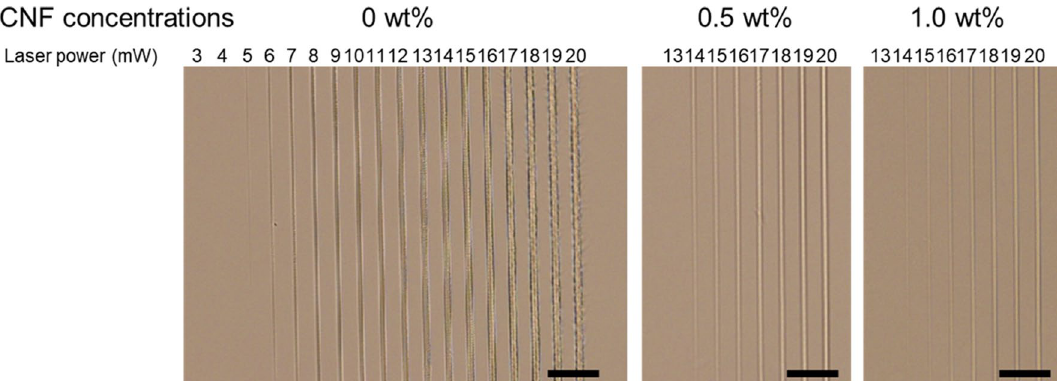
Figure 1. Optical microscope images of the fabricated microstructure by MPP at different concentrations of CNFs. The laser scanning speed was 50 µm/s. Scale bars indicate 50 µm.